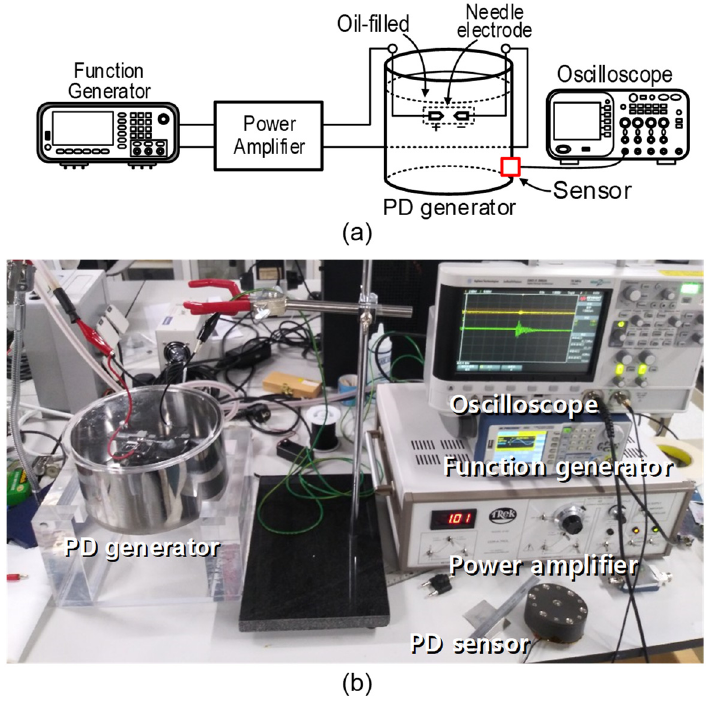
Figure 8. Experimental jig for modeling the PD in a pole-mounted transformer. ( a ) Schematic diagram for the jig and ( b ) experimental setup.